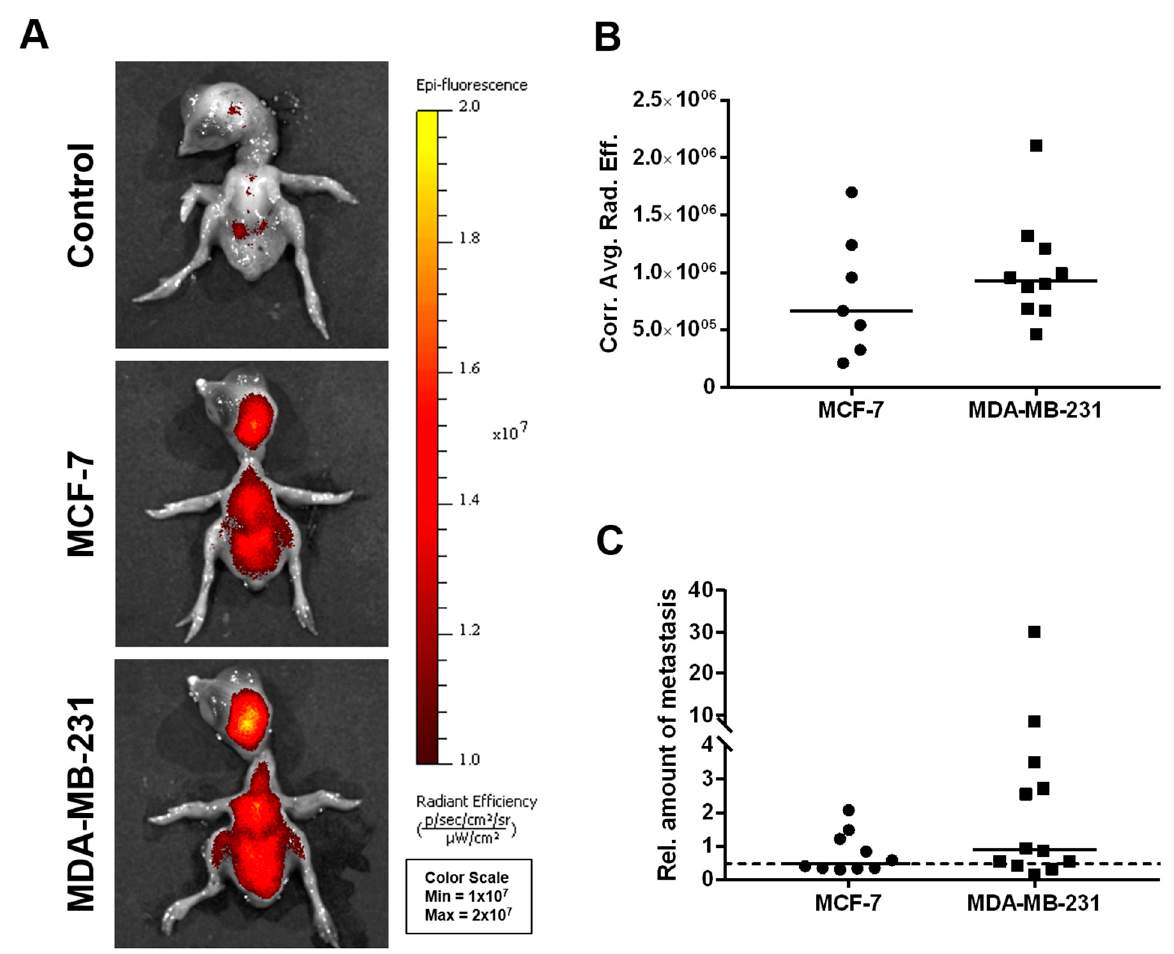
Figure 5. In vivo dissemination capability of MCF-7 and MDA-MB-231 breast cancer cells in the CAM xenograft assay. ( A ) Representative images of chicken embryos as obtained by fluorescence imaging 5 days post-engraftment of deep-red fluorescence-labeled MCF-7 and MDA-MB-231 breast cancer cell pellets onto the CAM (unlabeled cells of both the MCF-7 and MDA-MB-231 cell lines served as controls). ( B ) Corrected average radiant efficiency as assessed by fluorescence imaging in chicken embryos to determine the in vivo dissemination potential of MCF-7 ( n = 7) and MDA-MB-231 ( n = 10) cells. ( C ) Relative amount of disseminated tumor cells within the livers of chicken embryos as determined by human-specific Alu qPCR 5 days after engraftment of the breast cancer cell lines MCF-7 ( n = 10) and MDA-MB-231 ( n = 12). A value of 1 serves as a reference and indicates an amount of 0.01 ng/mL of human genomic DNA. The dotted line represents the cutoff for tumor cell dissemination detection, which was defined by the sensitivity limit of the Alu qPCR method. Medians of all data are presented as lines in the graphs. For statistical analysis, the Mann ‒ Whitney test was used; the post-analysis was performed using Dunn’s multiple comparison tests.